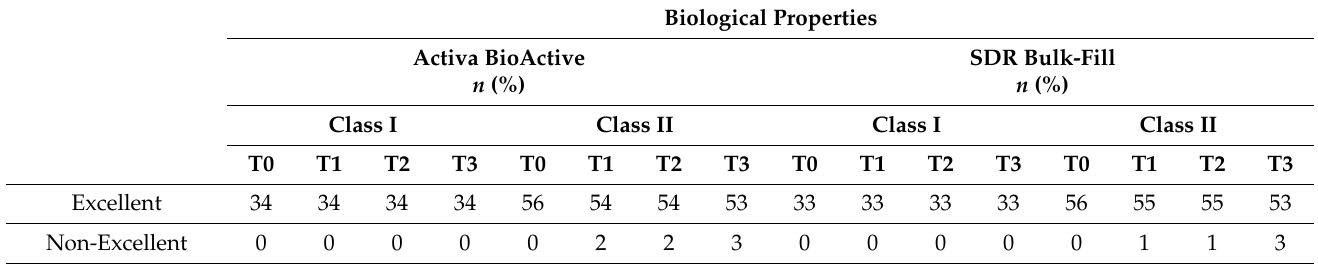
Table 10. Overall evaluation of Functional properties based on material used and restoration